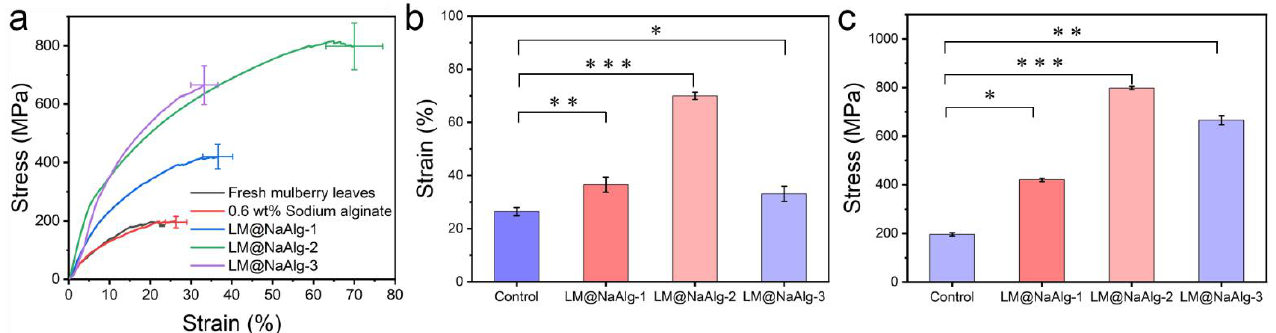
Figure 7. Typical stress – strain curves of the silk fibers. ( a ) Mechanical properties of the silk fibers modified with different concentrations of LM@NaAlg nanodroplets; ( b ) average stress histogram of control, LM@NaAlg-1, LM@NaAlg-2, and LM@NaAlg-3; ( c ) average strain histogram of control, LM@NaAlg-1, LM@NaAlg-2, and LM@NaAlg-3. Error bars represent standard deviations of three repetitive experiments ( n = 3). p < 0.05: *; p < 0.01: **; and p < 0.001: ***. Table 1. Summary of the mechanical property control-relative ratios of the silk fibers modified with different materials.